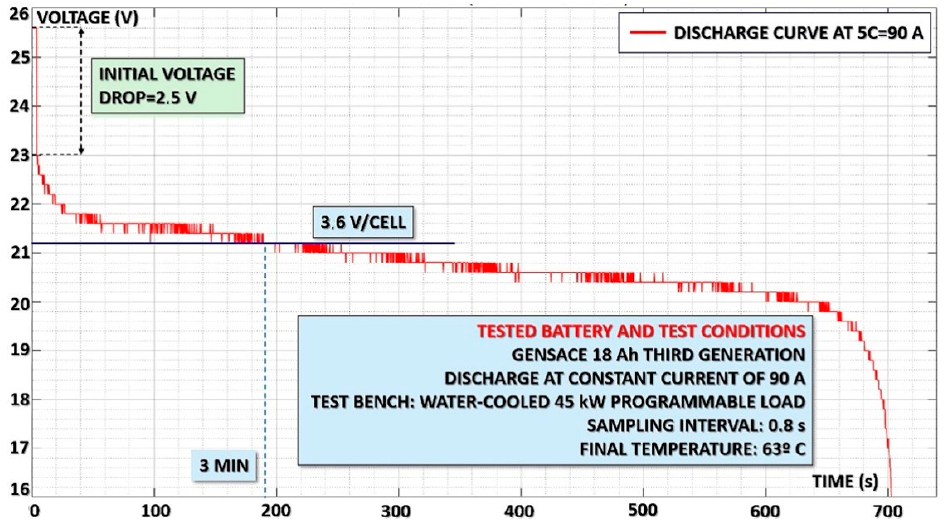
Figure 8. Discharge test of a third-generation GENSACE battery. Constant 90 A, 5 °C equivalent. The impossibility of this being used as a propulsion battery, even at 5 °C, is clear, although the manufacturer’s specifications indicate a maximum discharge of 15 °C.